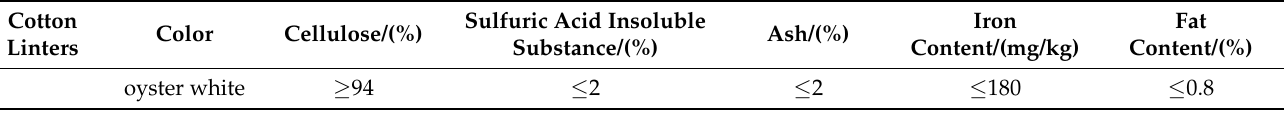
Table 1. Chemical composition of cotton